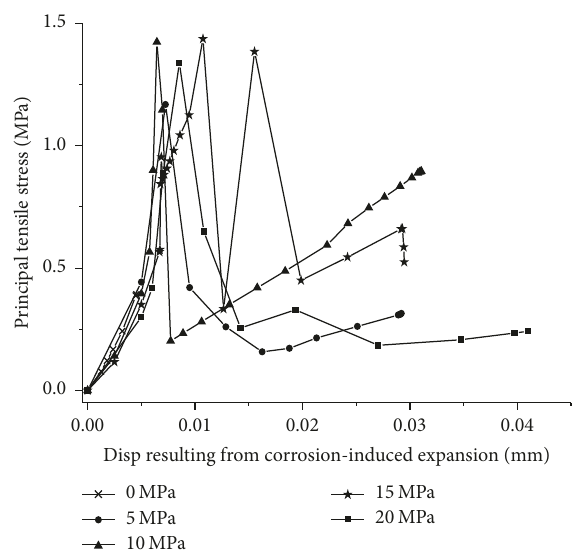
Figure 17: Load-principal tensile stress time-history curve for ele- ment 3.